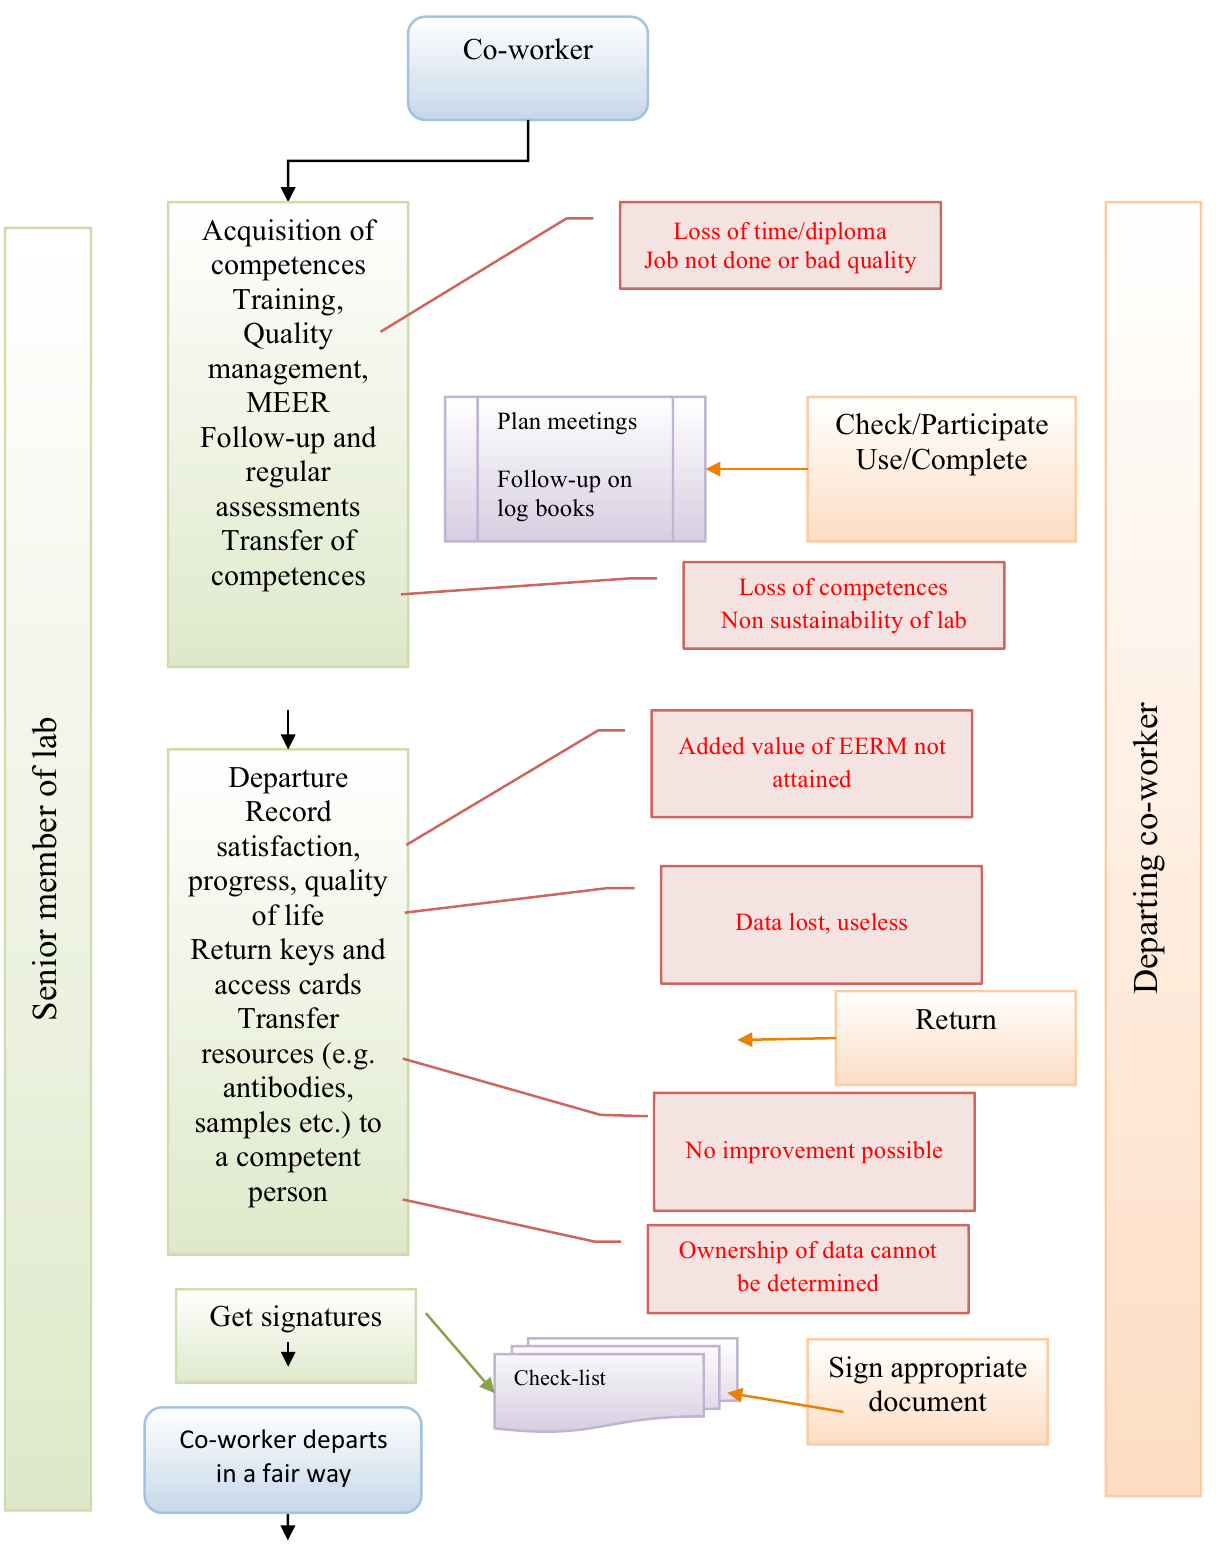
Fig. 6. Departure of a co-worker fl ow-chart with risky steps (indicated in